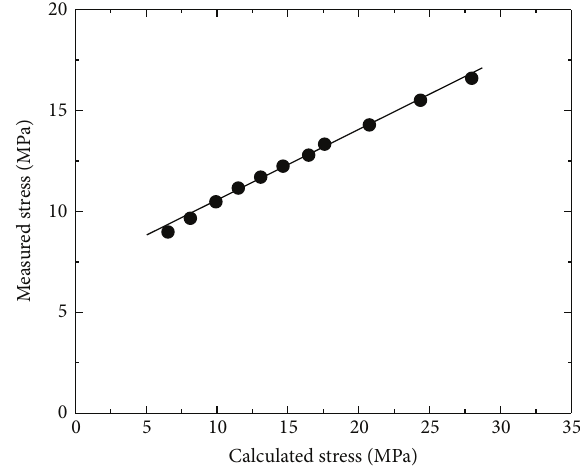
Figure 3: Calibration curve of the